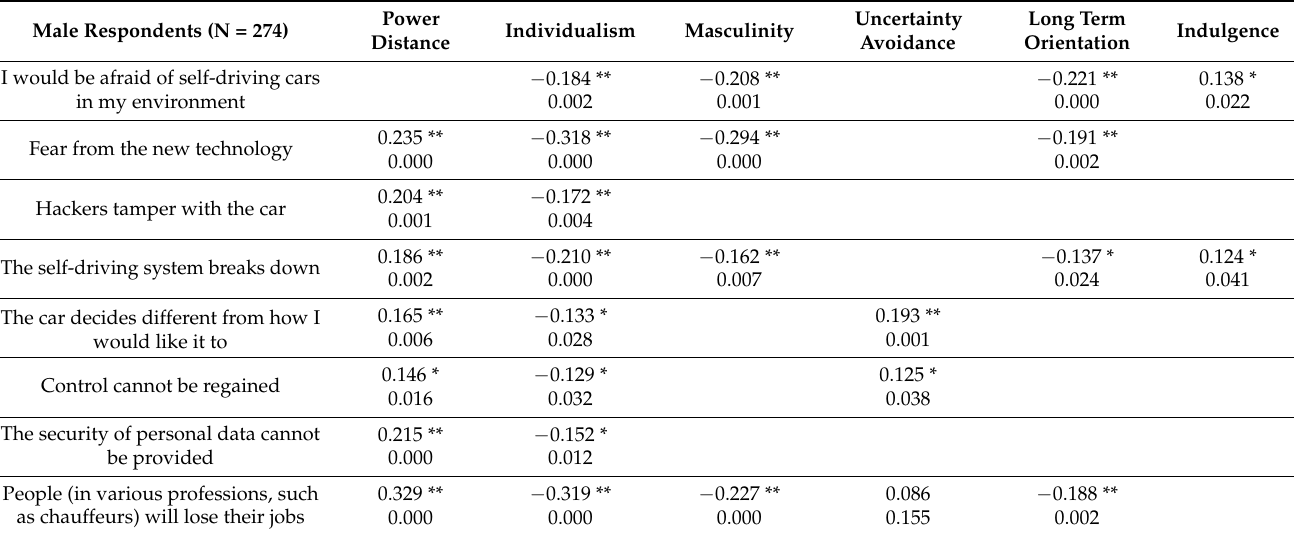
Table 5. The significant relations of cultural dimensions and perceptions of male respondents in the